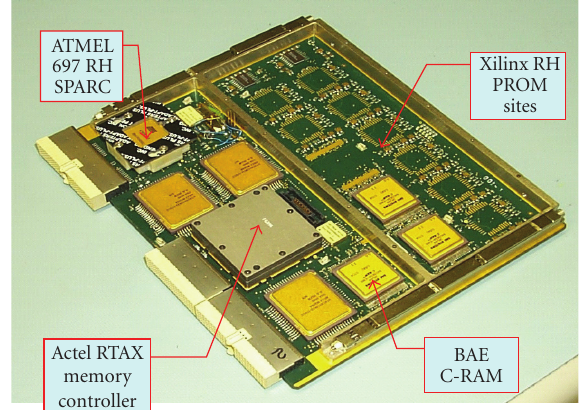
Figure 6: Flight computer board with radiation-hardened proces- sor, SRAM, and Xilinx PROM programming